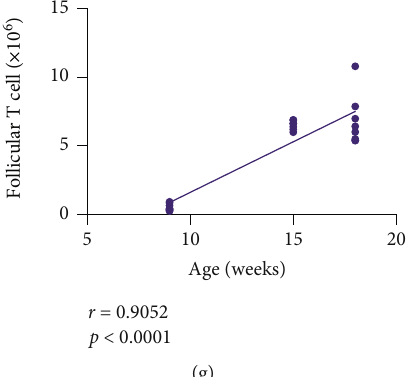
Figure 1: T cells increase in mice that develop lupus. In 9- and 18-week-old mice of the C57BL/6 and MRL/lpr strains, the following were FH determined: (a) concentration of anti-dsDNA antibodies by ELISA and (b) levels of proteinuria using a test strip. (c) Demonstration of the gating strategy for the fl ow cytometry analysis of T cells. Doublets were excluded by gating on FSC-H × FSC-A lymphocytes which were FH identi fi ed on the basis of their scatter properties (FSC-A × SSC-A plot), and live cells were gated in the Ghost Red − . The gate of CD4 + T cells was selected. The CXCR5 + PD1 + or CXCR5 + BCL6 + population represents T cells. (d) Percentage and (e) absolute number of T FH FH cells. Each determination was made in eight mice. Pooled data are presented as the mean ± SD; ∗∗∗ p < 0 : 001 using ANOVA. Pearson ’ s correlation between absolute number of T cells and (f) anti-dsDNA antibody concentration and (g) FH old, 0 : 11 ± 0 : 01 × 10 6 cells/spleen) (Figure 1(e)). Therefore,